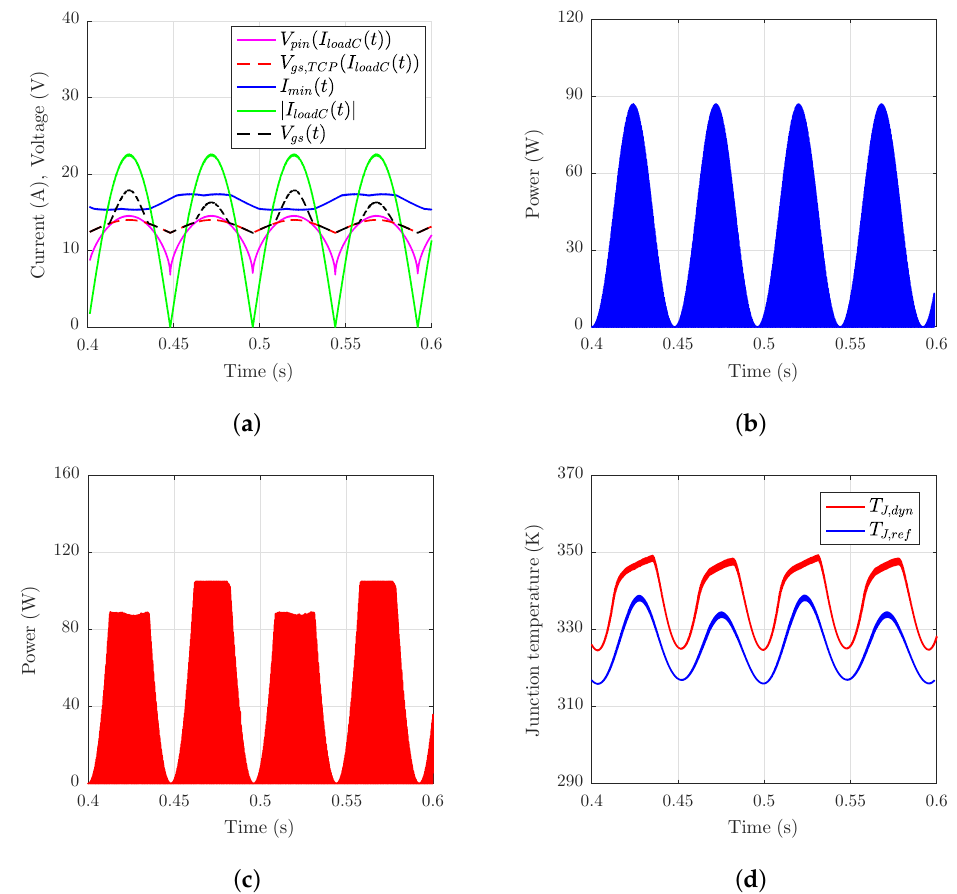
Figure 8. Simulation results of ( a ) Gate voltage profile and load current of phase C, ( b ) Conduction losses P ref of switch Cu with conventional 18 V two-level gate signal, ( c ) Conduction losses P dyn of switch Cu with the adjustable three-level gate signal, and ( d ) Junction temperature response under low speed operation condition.